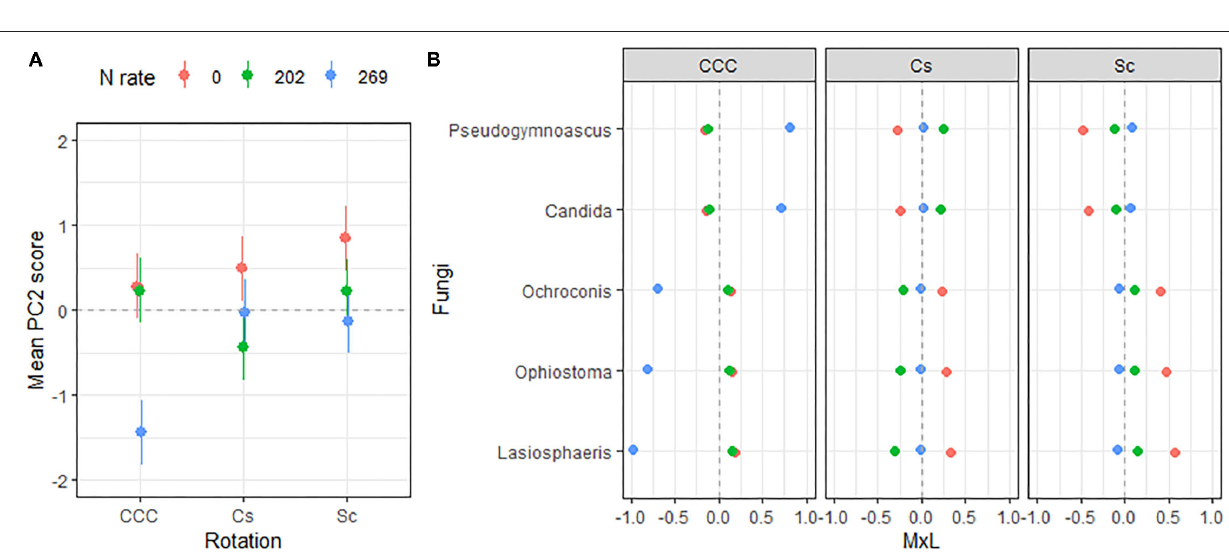
FIGURE 4 | (A) Mean value of the bacterial PC2 scores for each rotation at each level of N fertilization. Standard errors are indicated as whiskers. (B) Contribution of each indicator genera to the PC mean value (MxL) for each rotation (panels) at each level of N fertilization: CCC, continuous corn; Cs, corn phase of the corn-soybean rotation; Sc, soybean phase of the corn-soybean